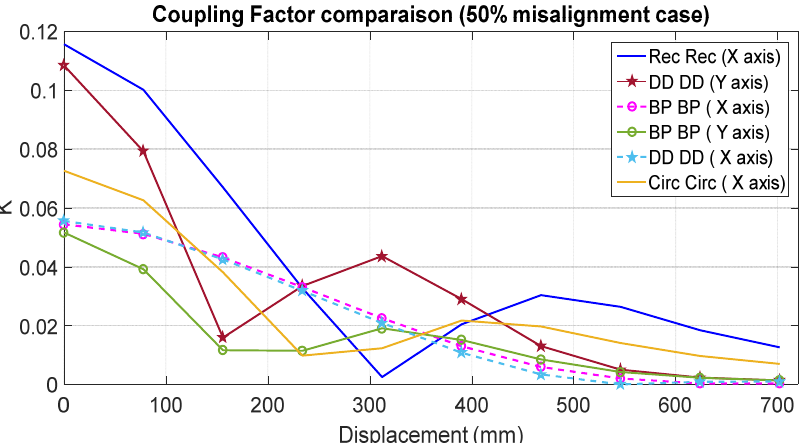
Figure 14. The displacement axes (with 50% misalignment).